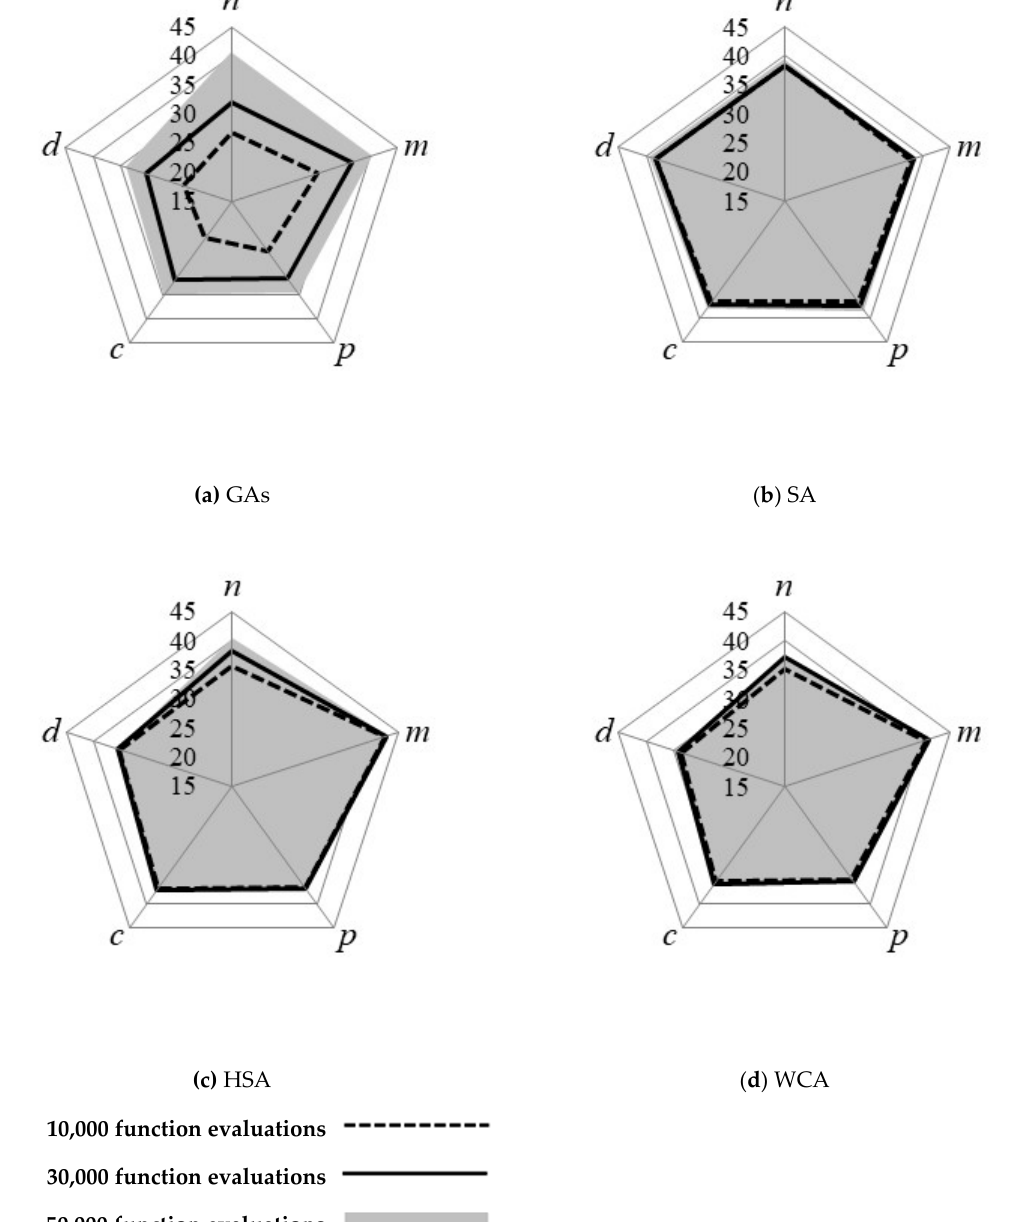
Figure 3. Performance comparison results (mean of average improvement ratio in percentage). ( a ) Genetic algorithms (GAs); ( b ) simulated annealing (SA); ( c ) harmony search algorithm (HSA); and ( d ) water cycle algorithm (WCA).